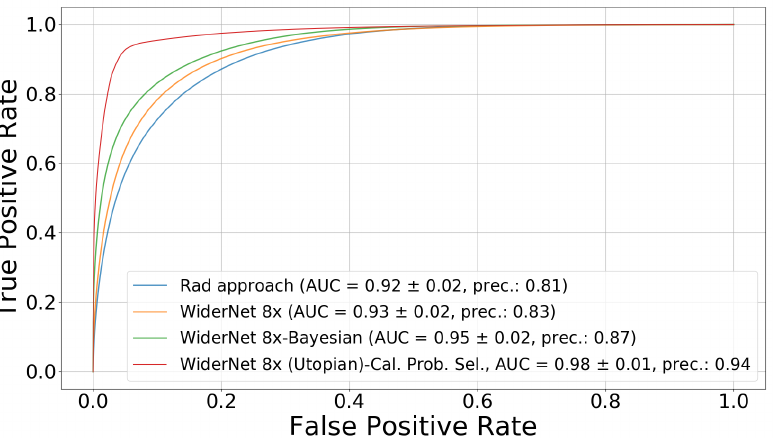
Figure 10. Comparison for ESDB dataset considering a Utopian case where ground truth values are also removed if the associated calibrated probability is smaller than the selection threshold. Best viewed in